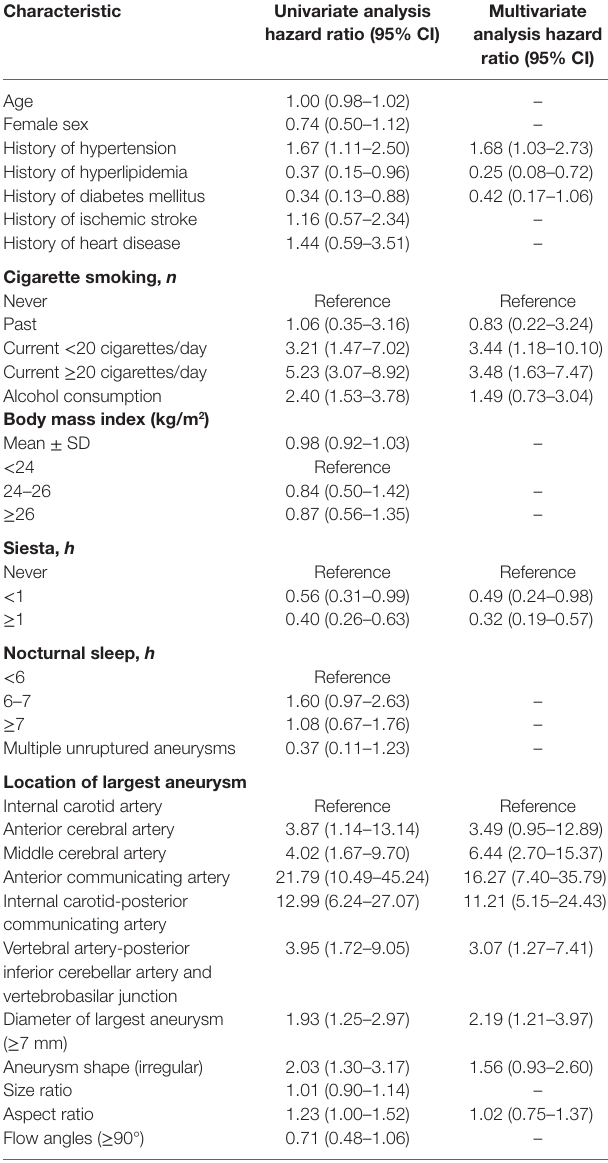
TaBle 3 | Univariate and multivariate regression analysis for rupture of intracranial aneurysms.